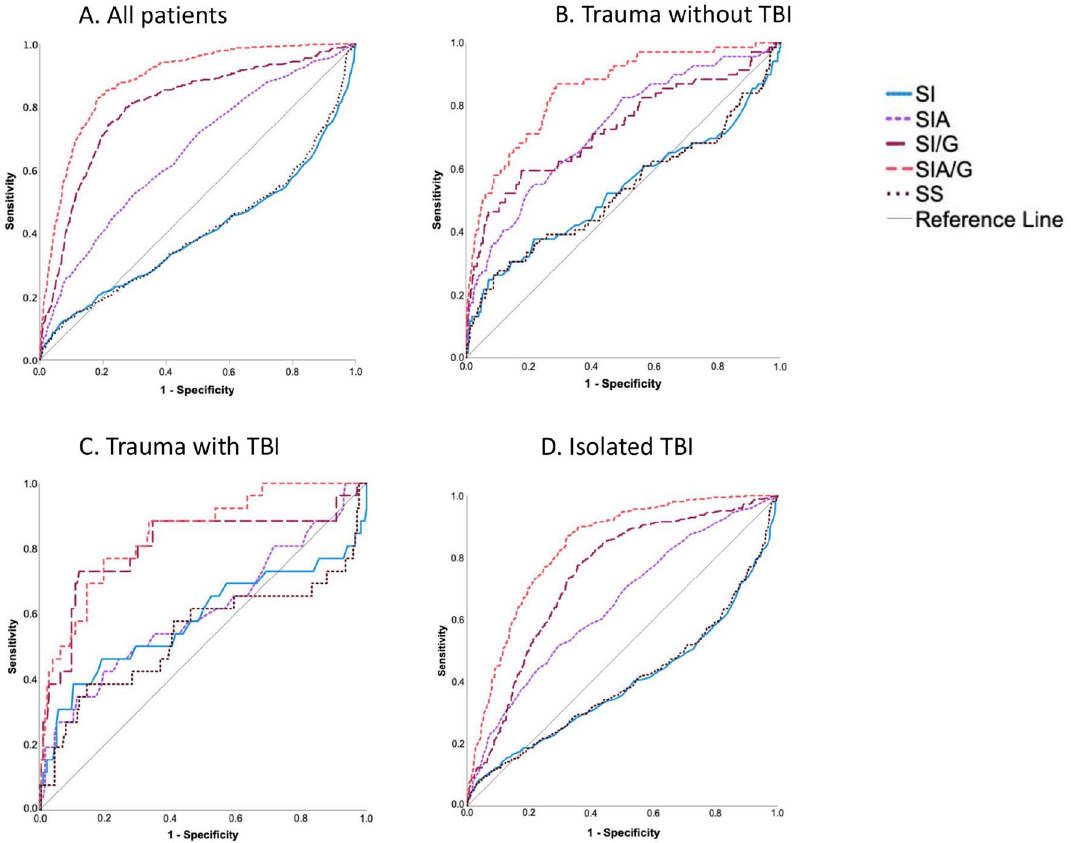
Figure 2. Receiver operating characteristic curves for the different shock index modifications for all patients and subgroups. The number of patients varies depending on the amount of missing data needed to calculate specific indexes. TBI, traumatic brain injury; SI, shock index; SIA, SI multiplied by age; SI/G, SI divided by Glasgow Coma Score; SIA/G, SI multiplied by age and divided by Glasgow Coma Score; SS, SI divided by oxygen